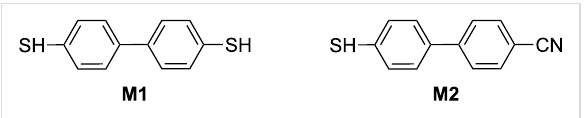
Figure 2: Chemical structures of [1,1’-biphenyl]-4,4’-dithiol ( M1 ) and 4’-mercapto-[1,1’-biphenyl]-4-carbonitrile ( M2 ).